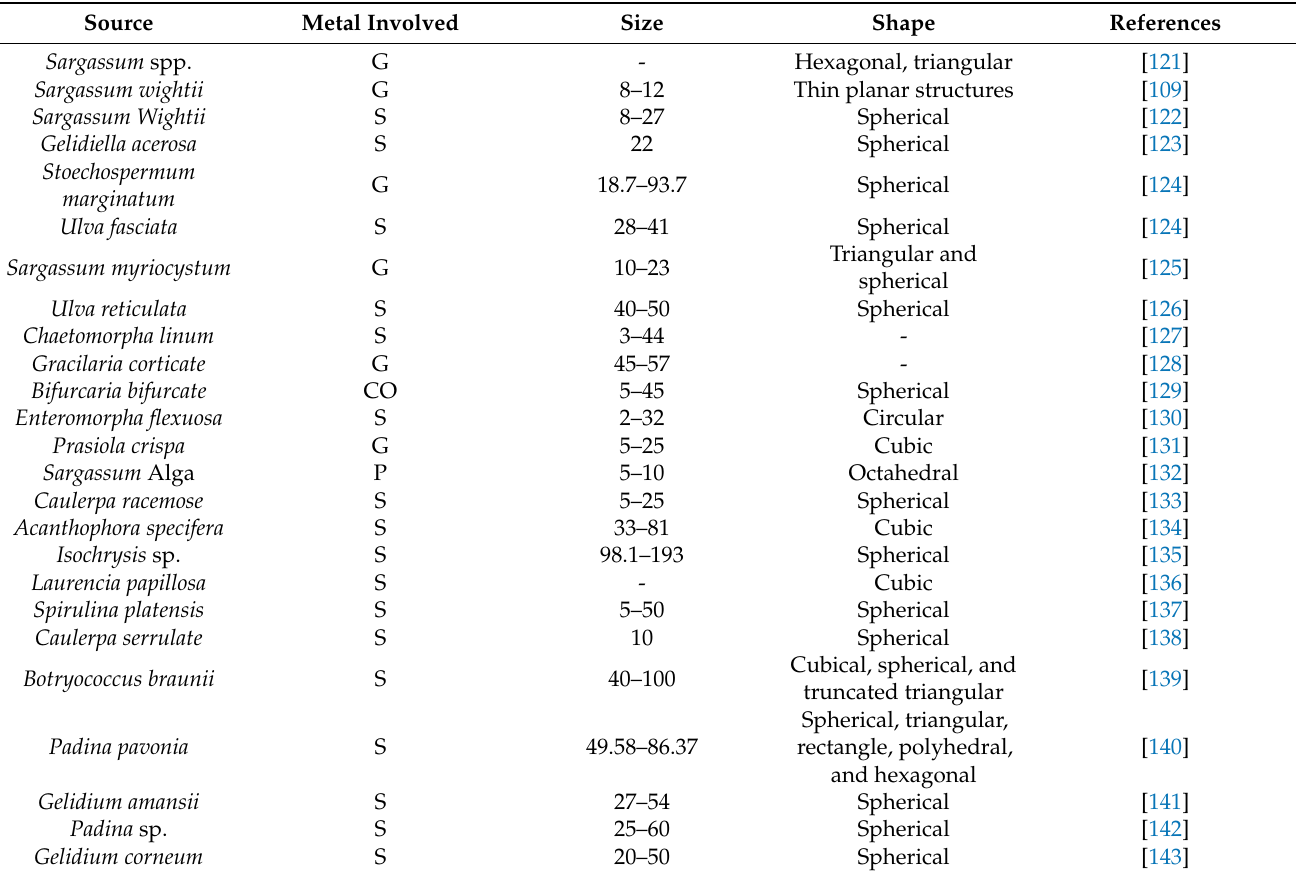
Table 3. Nanoparticles synthesized from